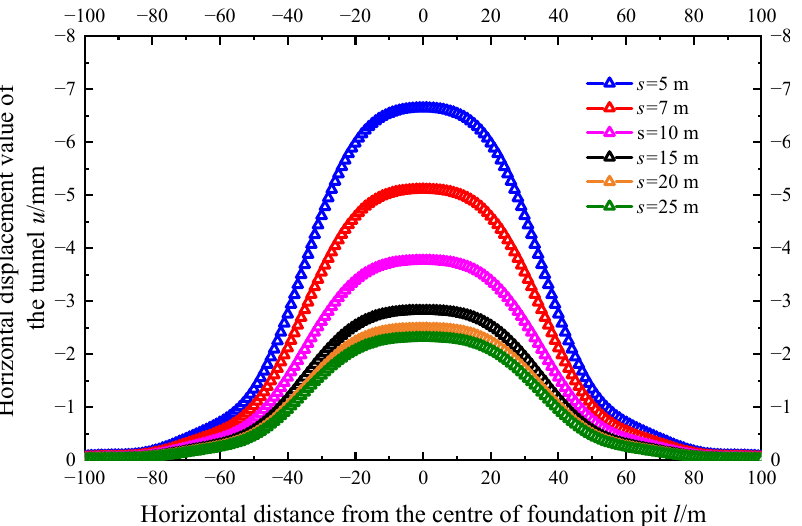
Figure 17. The longitudinal distribution curve of the horizontal displacement of the shield tunnel by the side of the foundation pit under different s conditions.